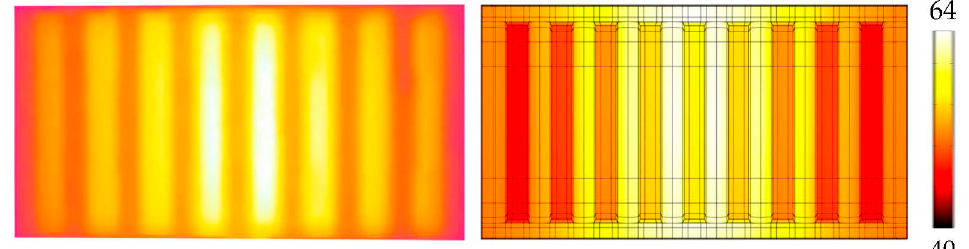
Figure 13. Thermal picture from the experiment and its comparison with the simulated temperature